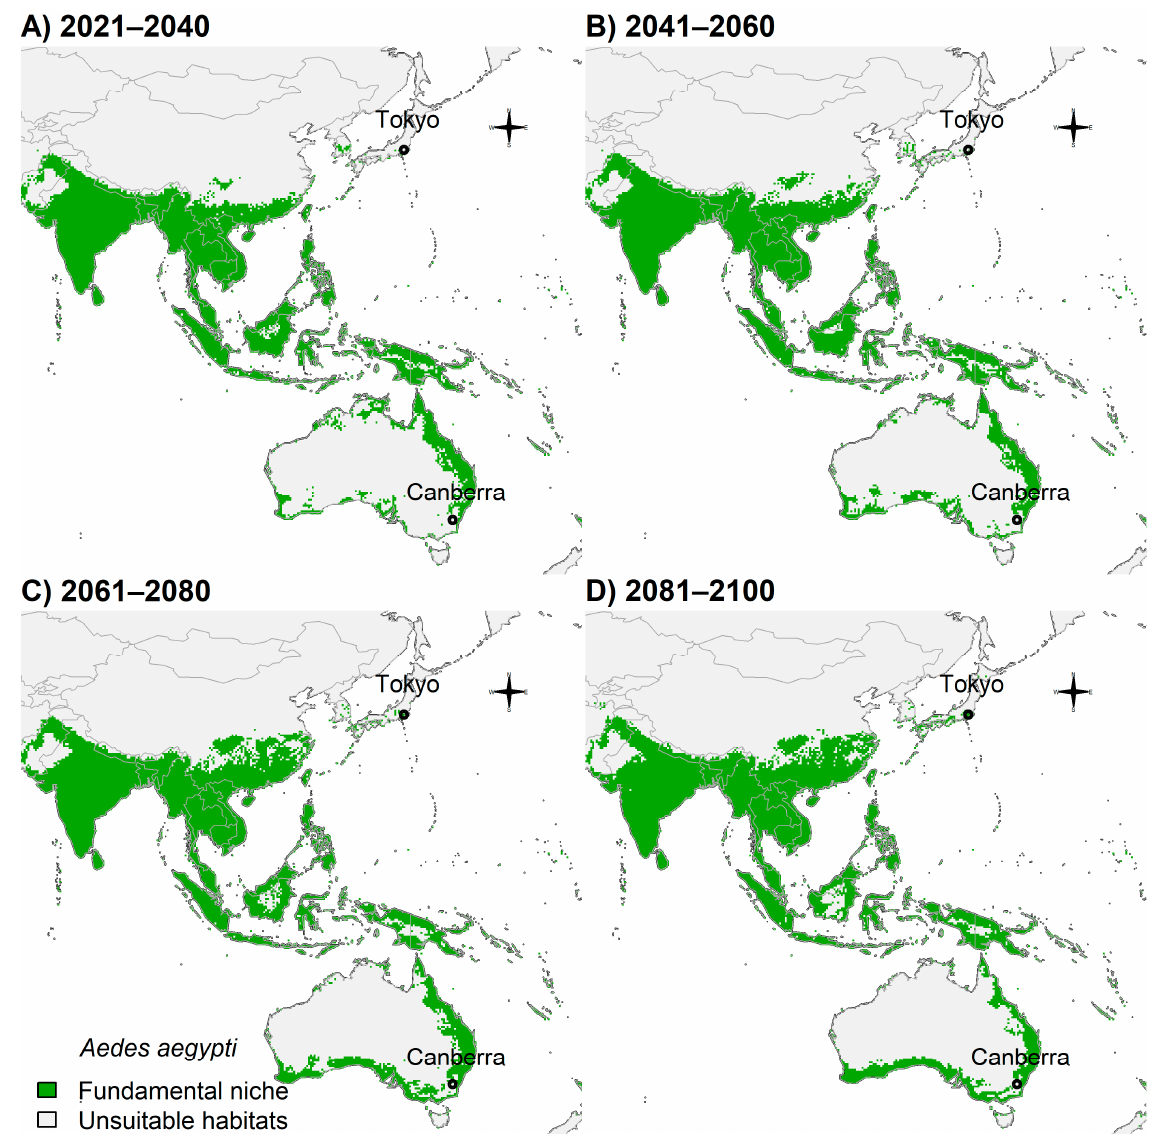
Figure 5. Potential future distribution of Ae . aegypti in Asia and Oceania: ( A ) 2021–2040; ( B ) 2041–2060; ( C ) 2061–2080; and ( D ) 2081–2100. Future climate projections based on the global climate model GFDL-ESM4.1 by NOAA in the shared socio-economic pathway SSP3-7.0 of region rivalry. Locations of capitals of countries were shown for reference.